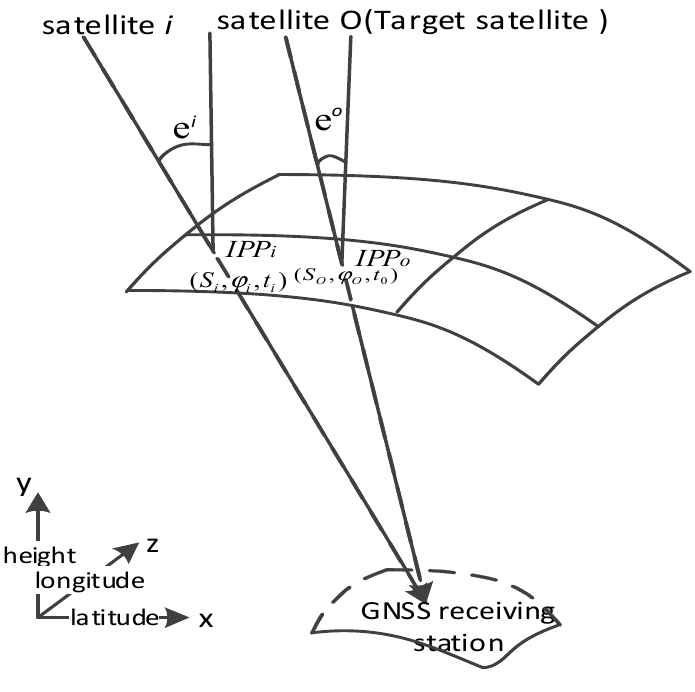
Figure 3. Schematic of the self-adaptive grid method.